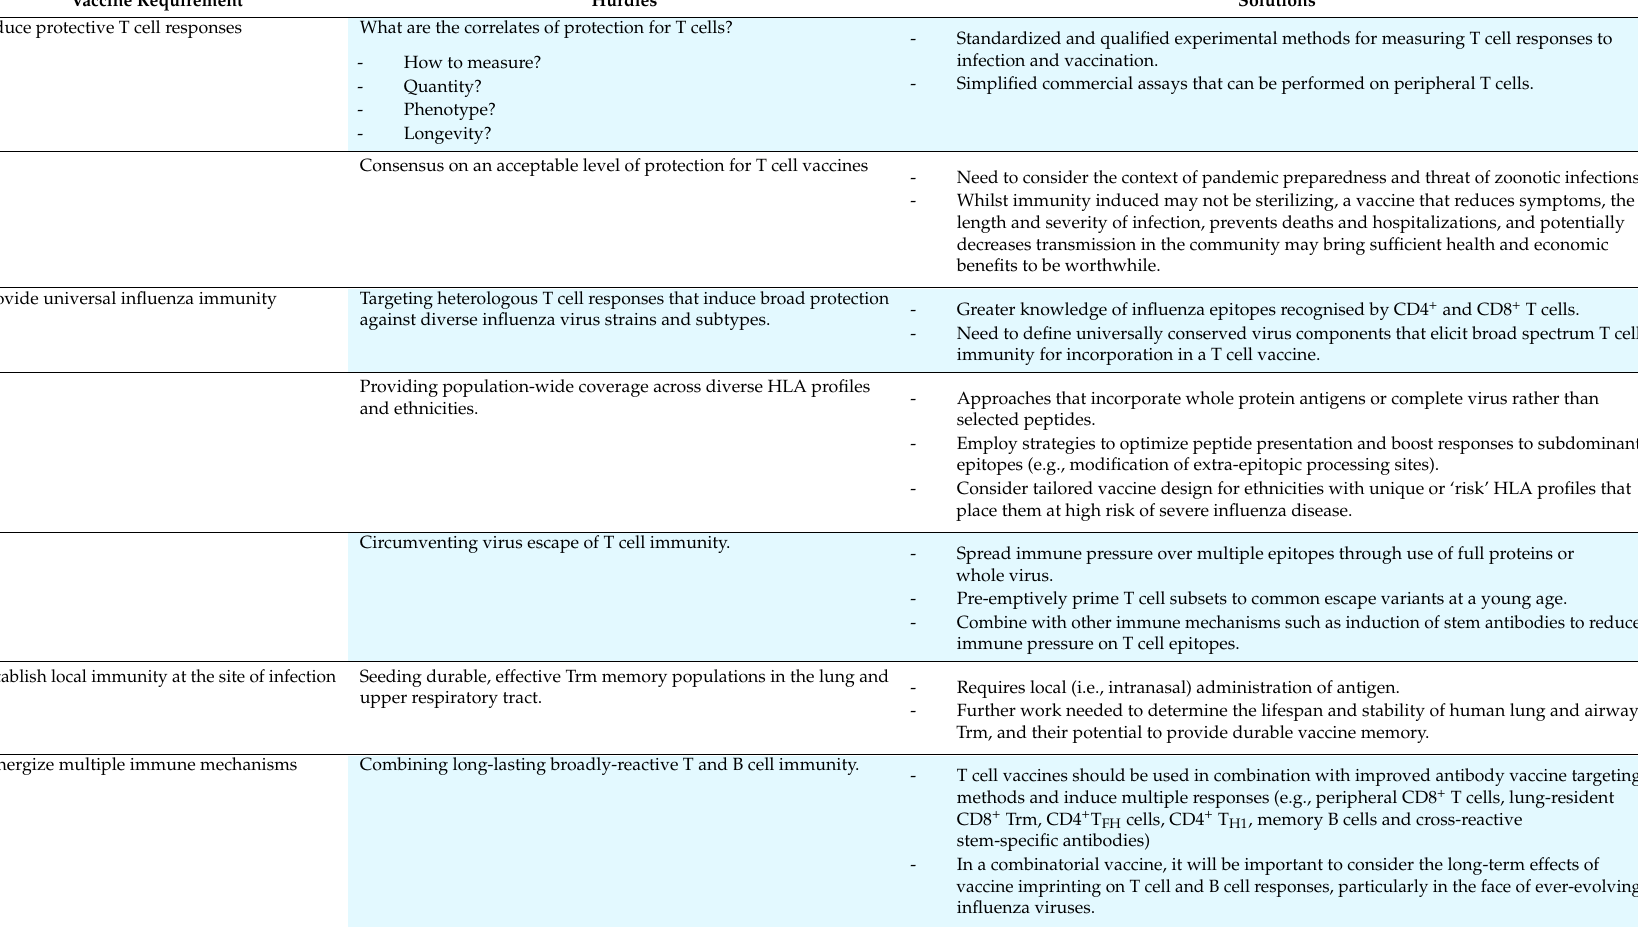
Table 1. Considerations for the design of a universal T cell vaccine of the future.